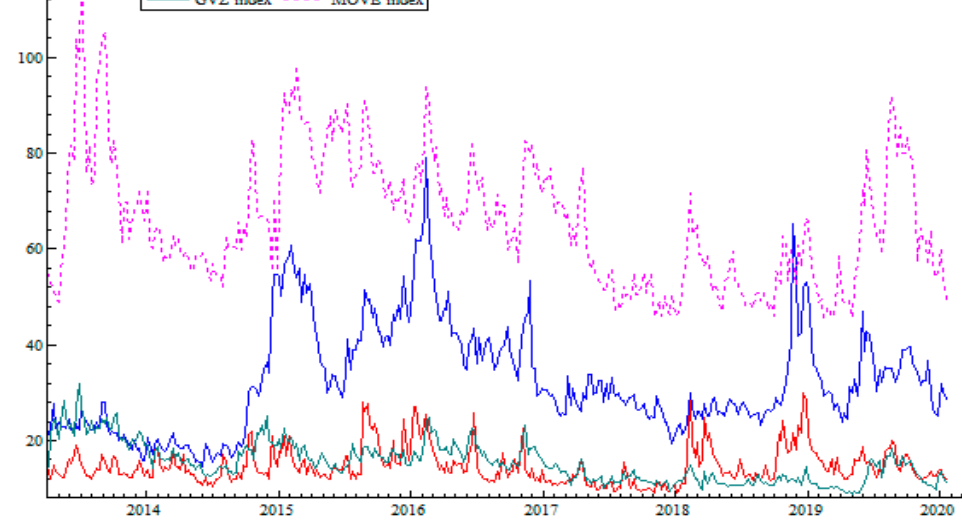
Figure 3. Time trend of the various uncertainty indices (VIX, OVX, GVZ and MOVE indexes). Table 1. Data